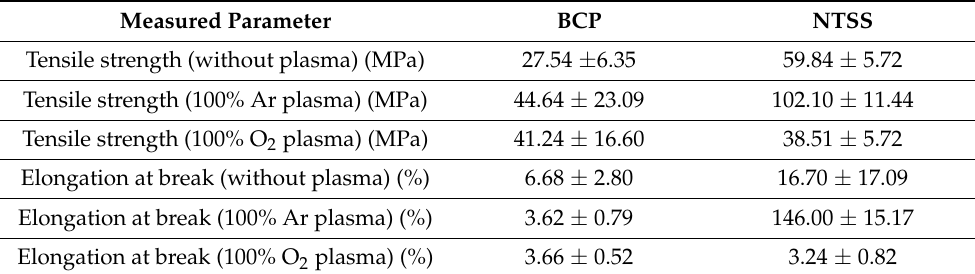
Table 4. Tensile properties of the film due to plasma